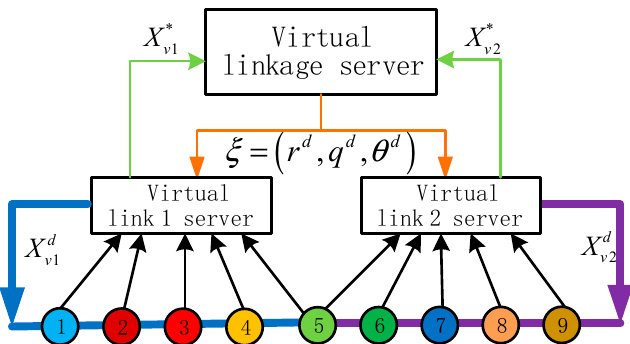
Figure 12. Detailed architecture of the hierarchical virtual linkage approach for simulation.